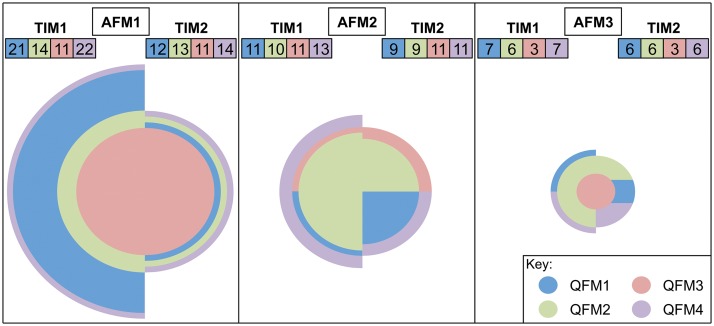
Impact of analysis parameters on the numbers of taxonomic units obtained for a bulk-bone sample.A number of analysis parameters were used to analyse a complex mixture containing numerous taxa. Different quality and abundance filtering methods were used in addition to two taxonomy-independent measures of analysis, full definitions and explanations of which are in Fig 1. The spread in the numbers of taxonomic units obtained across the combinations of parameters chosen is seen. The radius of each semicircle represents the number of taxonomic units obtained given a set combination of the parameters used. The number of taxonomic units is also indicated above each semicircle. Each semicircle is proportional to all others. AFM—abundance filtering method; QFM—quality filtering method; TIM—taxonomy-independent method.